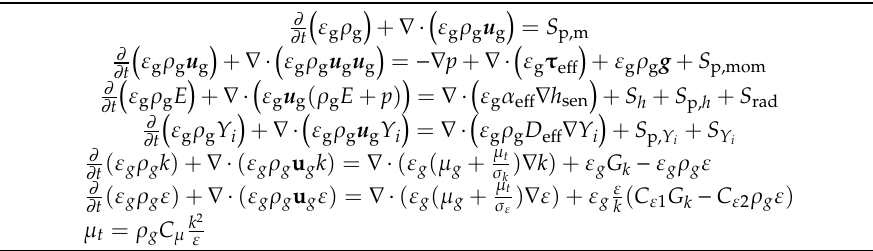
Table 1. Gas phase governing equations.